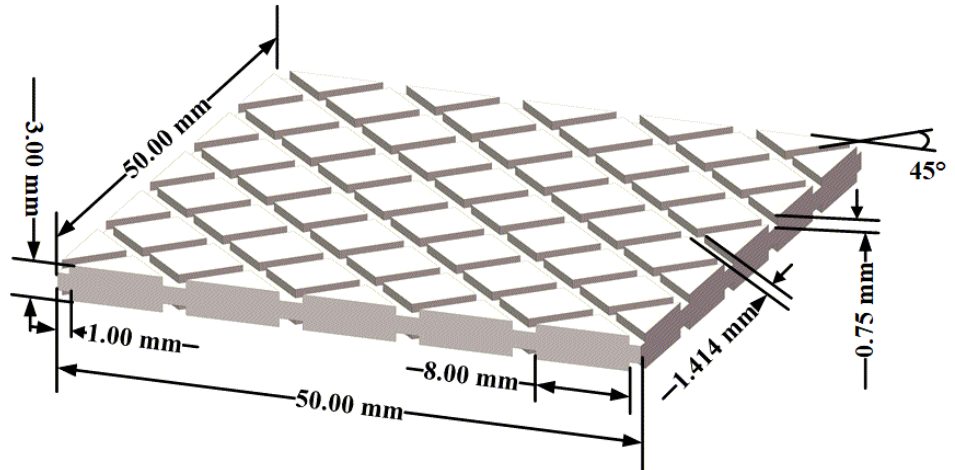
Figure 2. ±45° groove structure (area size: 50 mm × 50 mm).